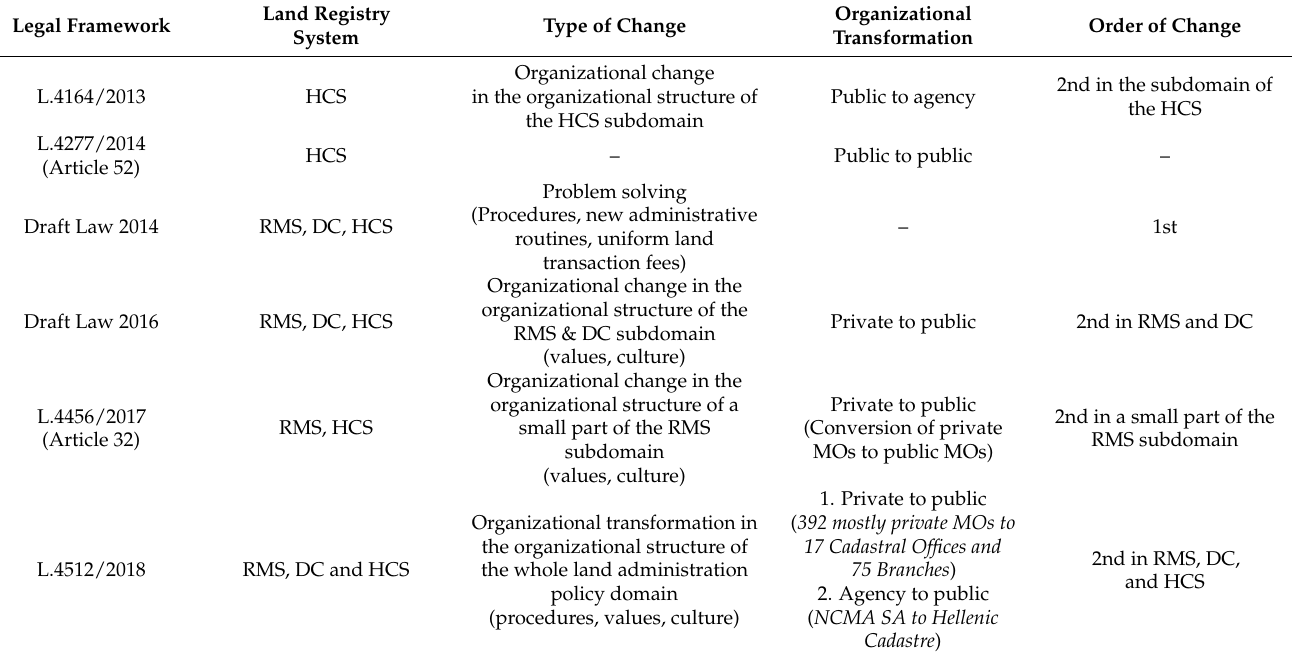
Table 2. Legislative initiatives in Greece’s LAOs from 2009 to 2018 through the orders of